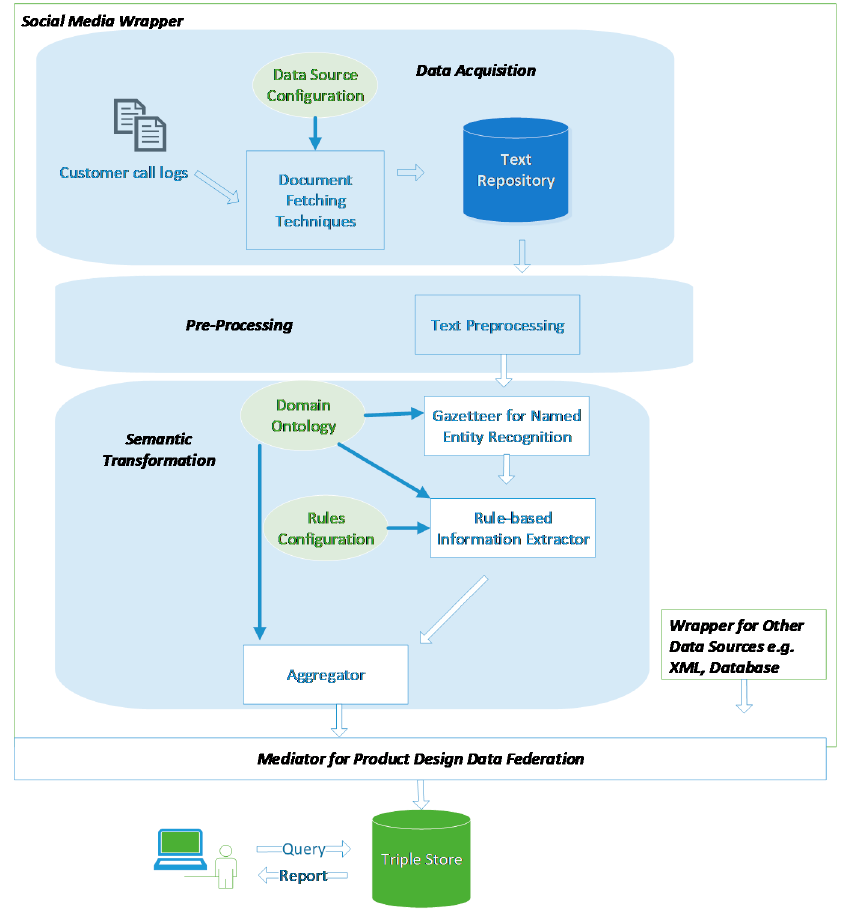
Figure 10. Social Media Wrapper Architecture.